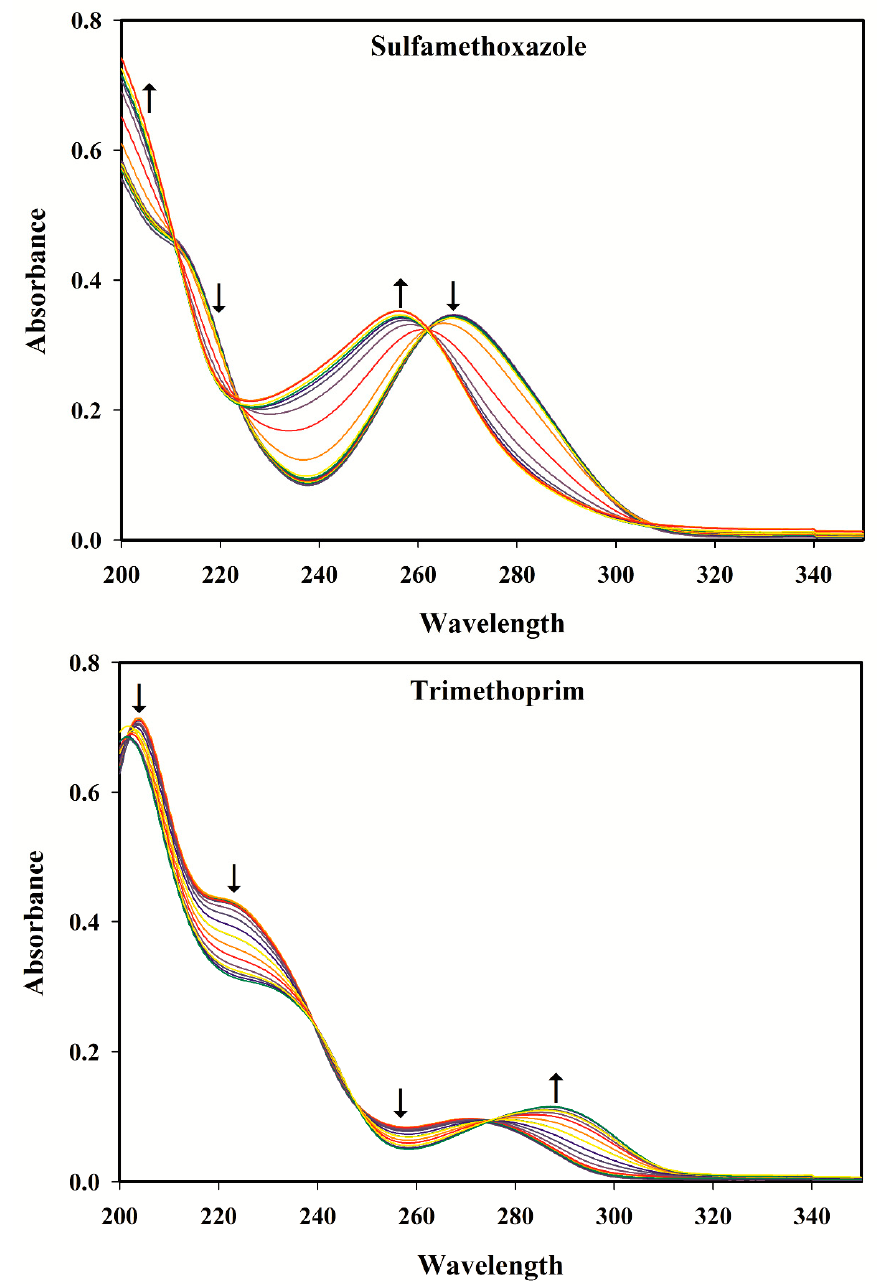
Figure 1. UV absorbance spectra of sulfamethoxazole (5.0 µg mL -1 ) and trimethoprim (5.0 µg mL -1 ) at different pHs (pH from 2 to 12 at intervals of 0.5).